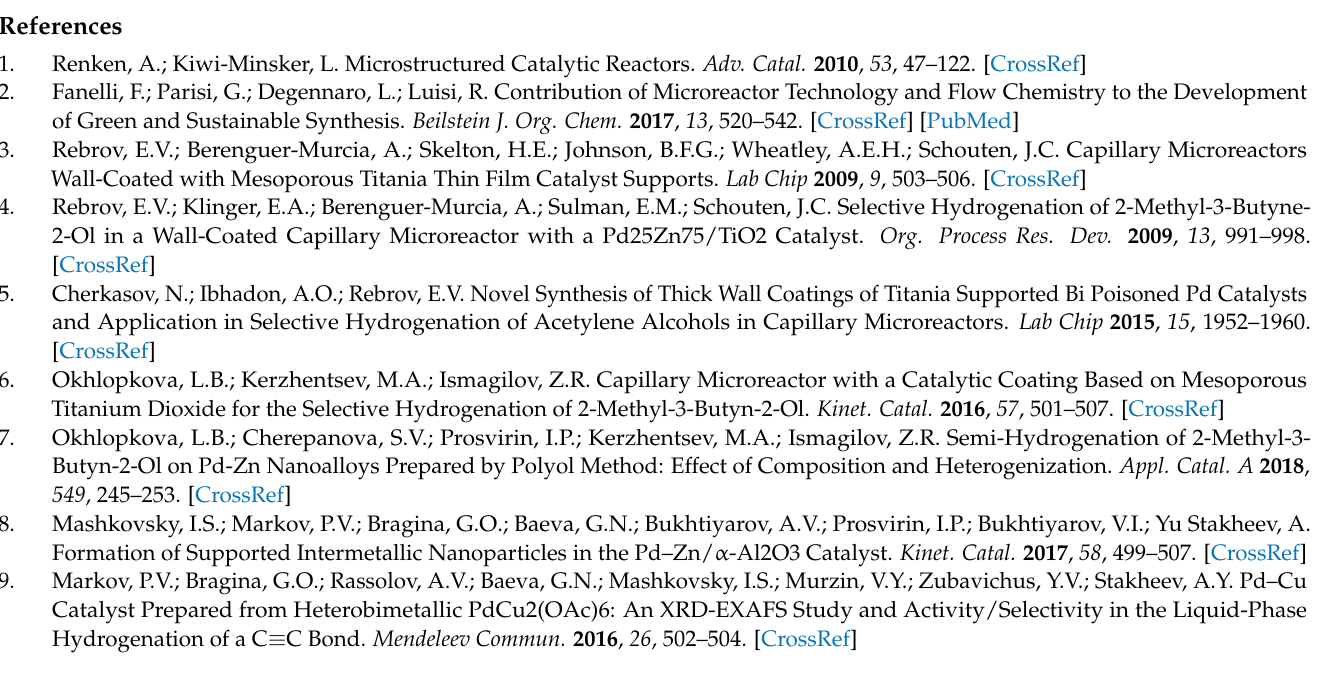
Langmuir-Hinshelwood model. Reaction conditions: gas flow rate 6.0 mL/min, = 1 atm, T = 313 K, Figure S8: TEM micrographs of the powdered catalysts (A) PdZn/TiO 2 -d, (B) PdZn/Ti 0.95 Ce 0.05 O 2 -d, Figure S9: Peak fitting of Pd3d 5/2 core-level spectra of (A) PdZn/TiO 2 -d , (B) PdZn/Ti 0.95 Ce 0.05 O 2 -d , and (C) PdZn/Ti 0.8 Zn 0.2 O 1.8 -d after calcination at 573 K in air and reduction with 30 vol.% hydrogen in argon at 573 K for 2 h, Table S1: Kinetic parameters of the hydrogenation reaction of MBY on films PdZn/TiO 2 after different pretreatments, Table S2: Kinetic parameters of the hydrogenation reac- tion of MBY on films PdZn/Ti 0.8 Zr 0.8 O 2 after different pretreatments, Table S3: Kinetic parameters of the hydrogenation reaction of MBY on films PdZn/Ti 0.95 Ce 0.05 O 2 after different pretreatments, Table S4: Kinetic parameters of the hydrogenation reaction of MBY on films PdZn/Ti 0.8 Zn 0.2 O 1.7 after different